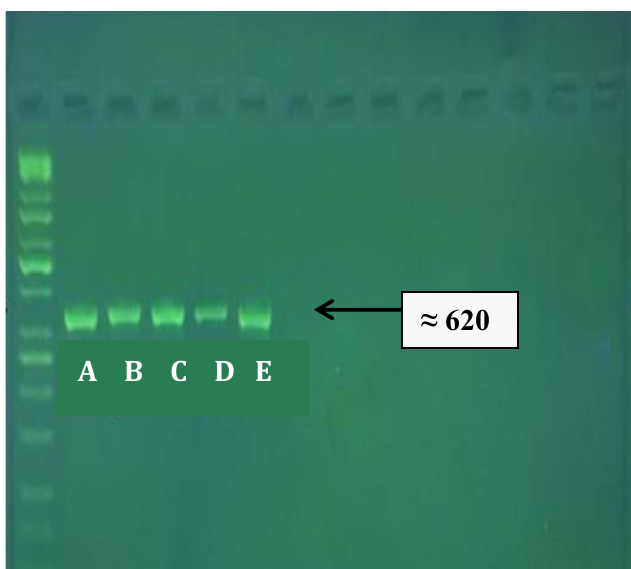
Figure 2. Gel electrophoresis of A= Duhok, B= Barzan-Erbil, C= Khabat-Erbil, D=TaqTaq-Erbil and E=Sulaymaniyah. Lane 1: DNA ladder (1000 bp), Lanes 2, 3, 4, 5, and 6: PCR products with the band sizes of approximately 620 bp stained by Red